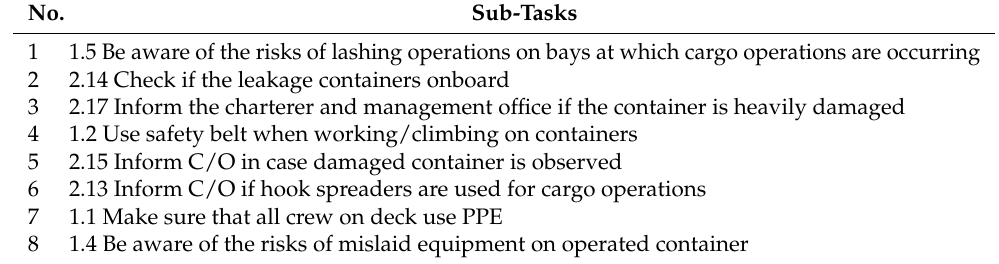
Table 7. Sub-tasks with the highest HEP.